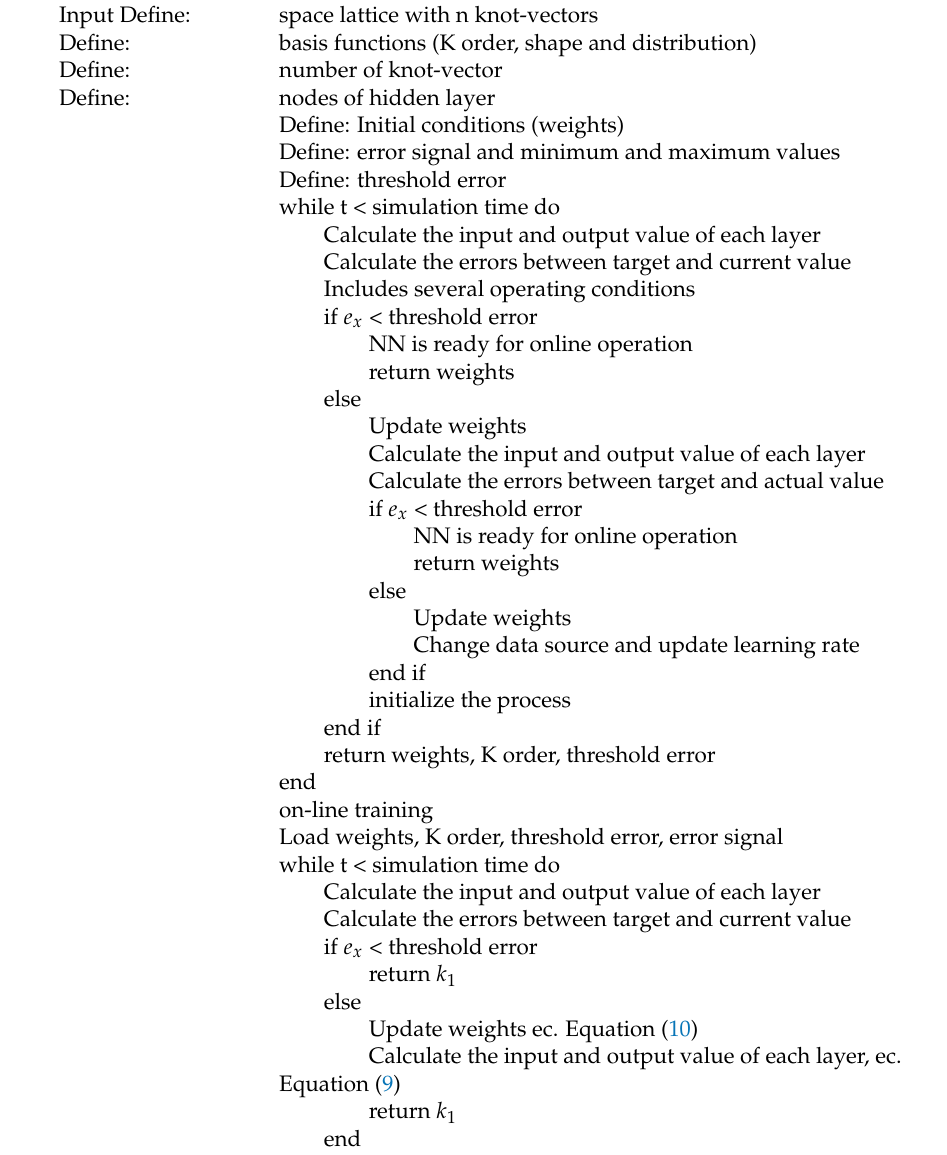
Table 4. 1: B-Spline Neural Network off-line training